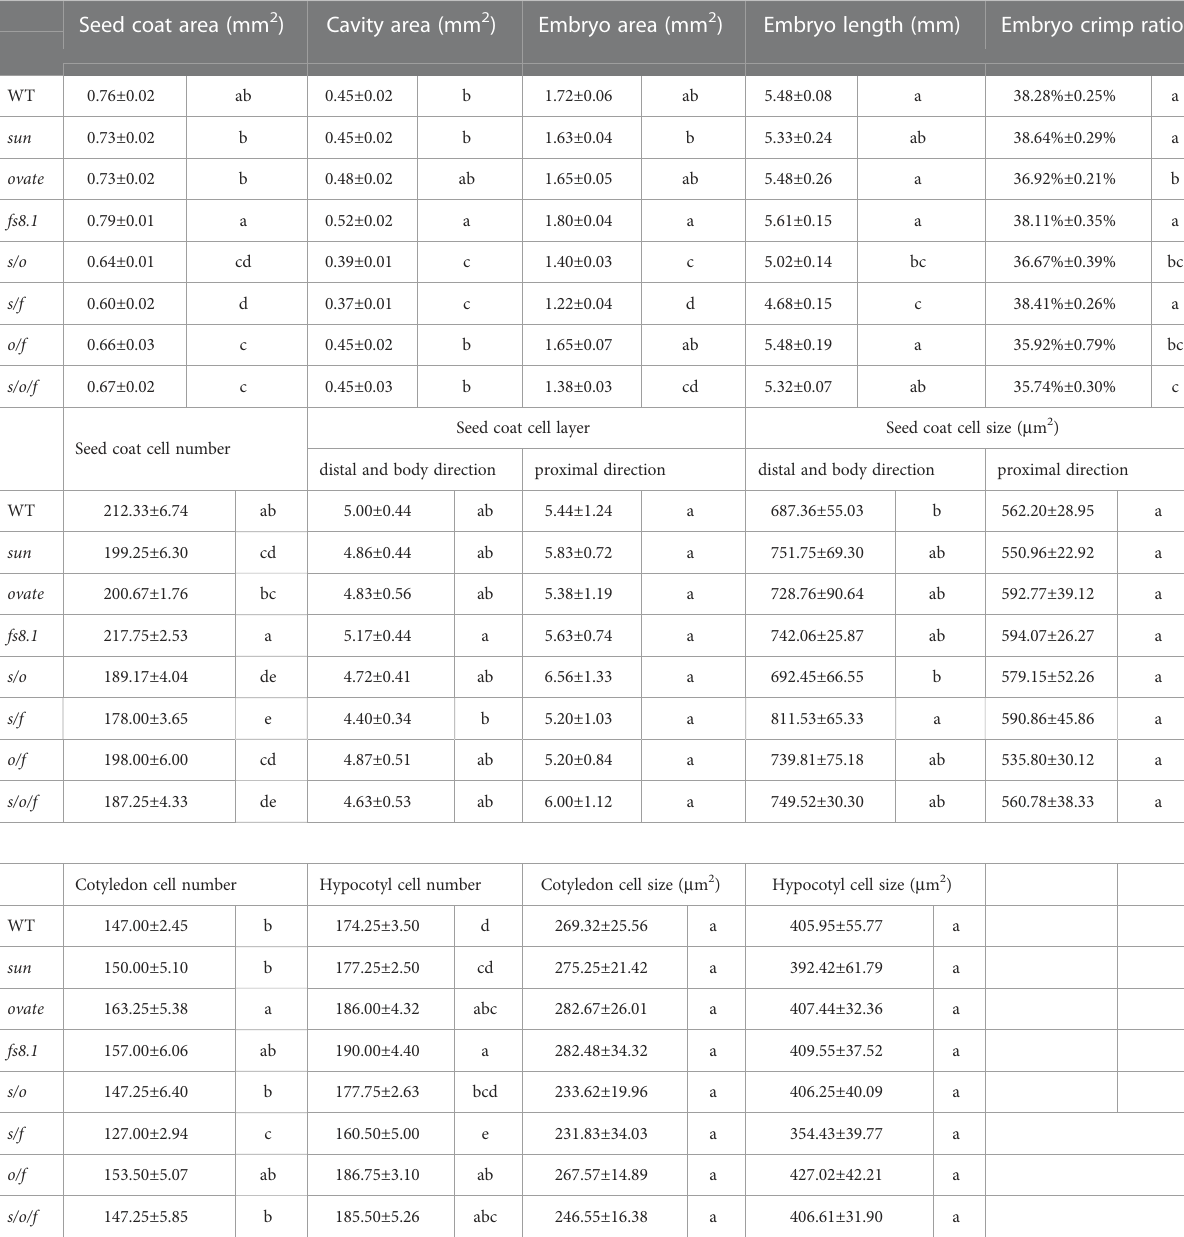
TABLE 3 Morphological and histological analyses of internal organs of mature seeds in sun , ovate and fs8.1 NILs. . Seed coat area (mm 2